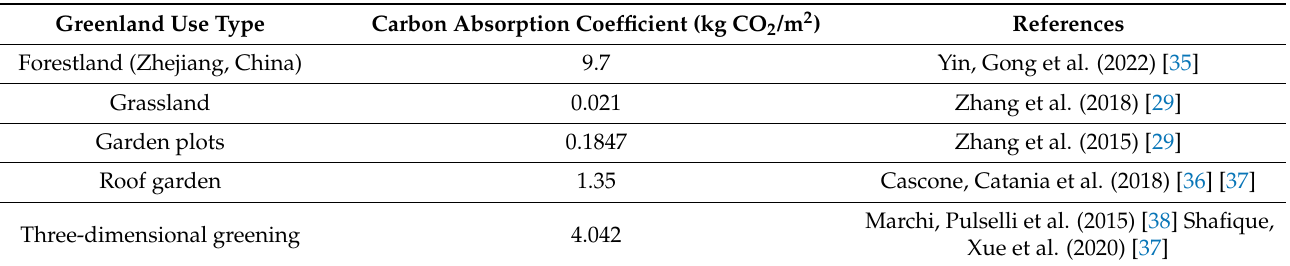
Table 6. Carbon emission factors for different types of green